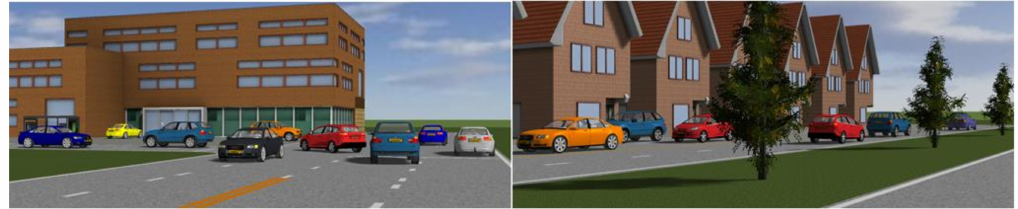
Figure 7. Part layout of the experiment scenes display, including model, colors, and shielding of